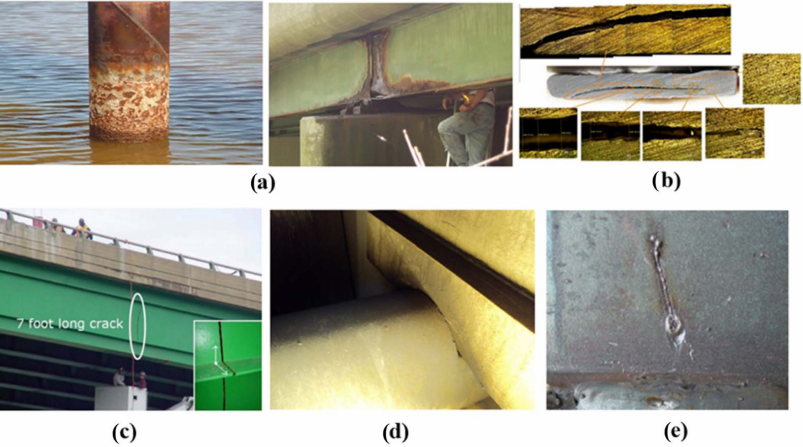
Figure 1. Most common deficiencies in steel bridges: ( a ) Corrosion [5–7]; ( b ) Delamination [8]; ( c ) Cracks [9]; ( d ) Top chord plate wearing groove into a top chord pin [10]; ( e ) Surface blemishes (welding arc strike on surface of steel plate)